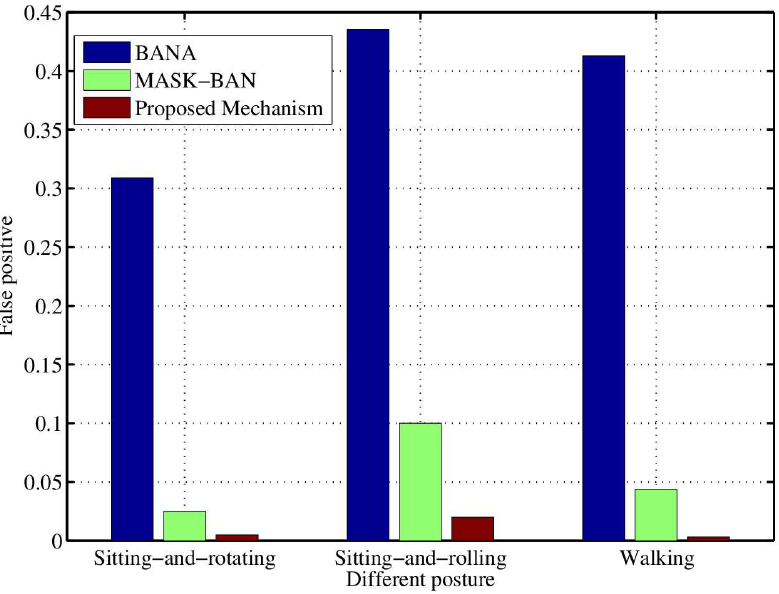
Figure 4. The influence of various actions on the false probability of